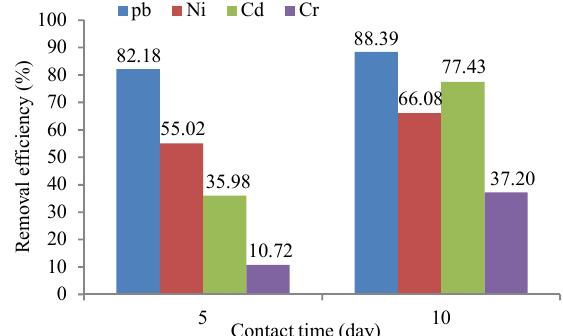
Fig. 2. Duckweed efficiency in separate heavy metal removal at concentration of 5 mg/l (duckweed weight: 0.2